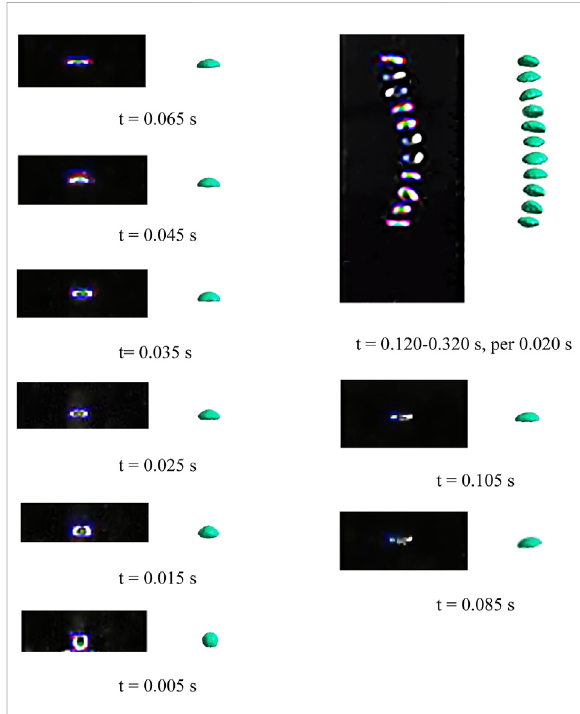
FIGURE 4 Comparison of experiments and 3D simulation of the bubble rising in water, d (cid:1) 4 mm .